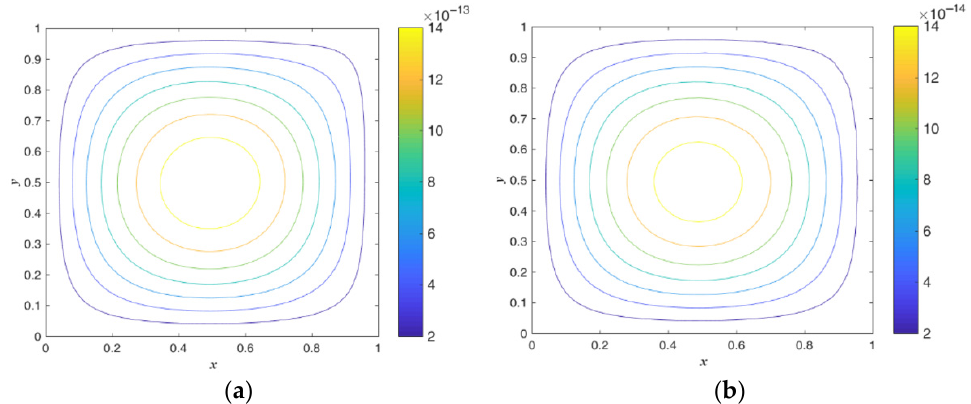
Figure 11. The absolute error distributions for a nonlinear Poisson problem: ( a ) EM; ( b ) RK4.